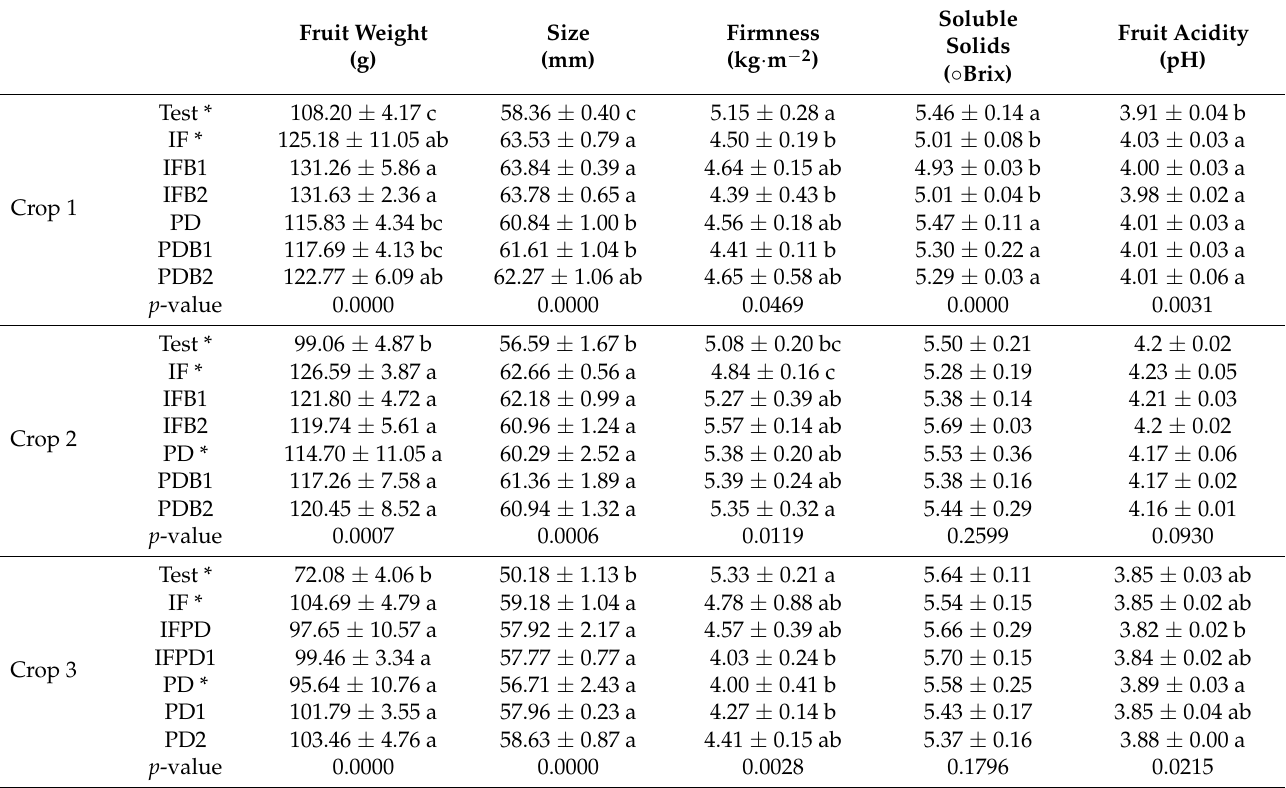
Table 6. Tomato fruit yield and quality parameters in the three years of study (September–April cycles) as a function of crop nutrition. Values (mean ± standard deviation).